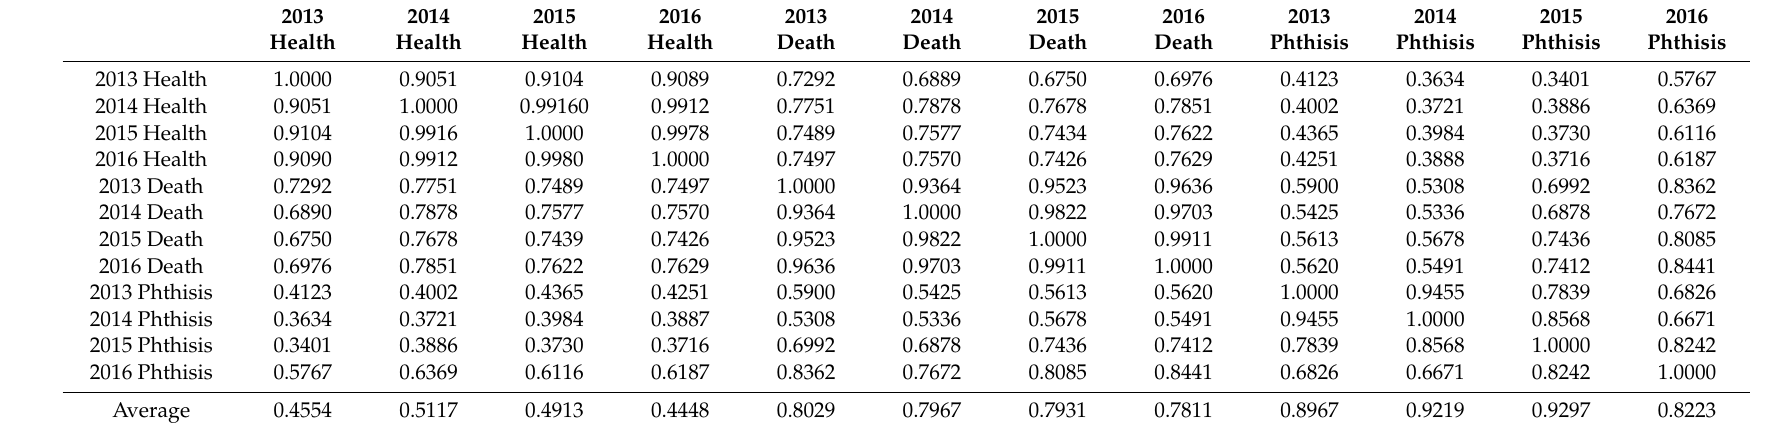
Table 9. Health, Dealh, and Phthisis E ffi ciency Value Correlation Test from 2013 to 2016.